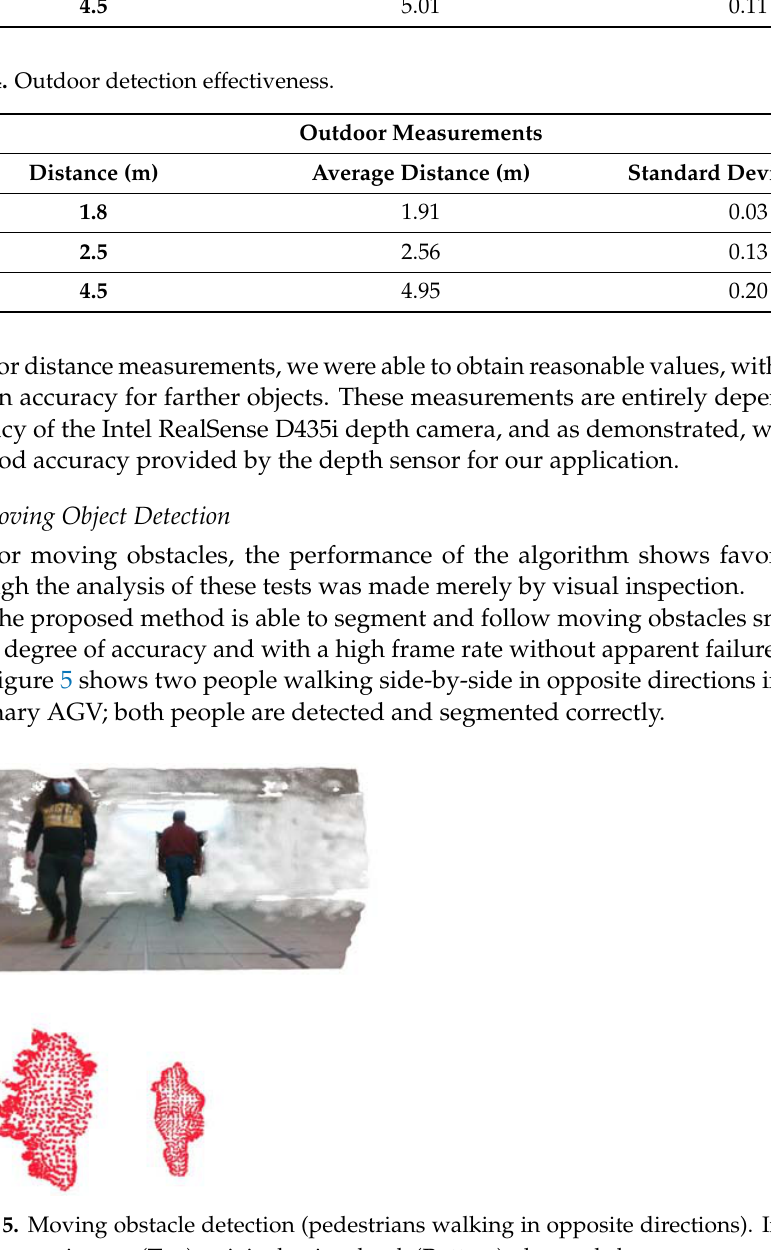
Table 4. Outdoor detection effectiveness.